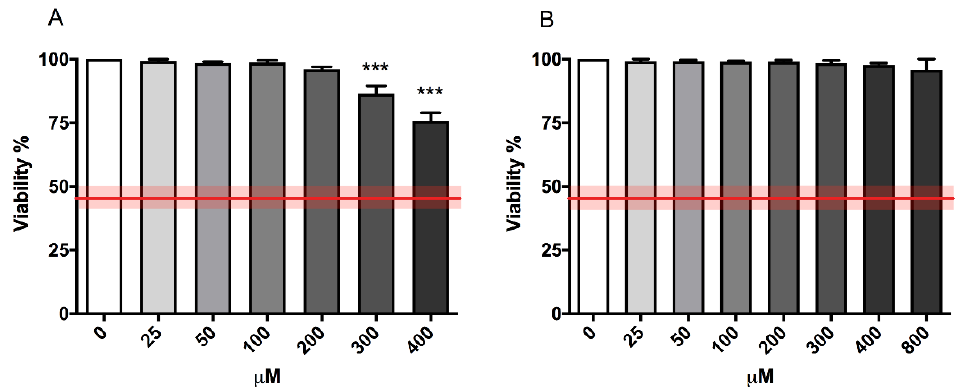
Figure 1. Cell viability of TK6 cells after 26 h treatment with ( ± )cis-4,4 (cid:48) -DMAR ( A ) or ( ± )trans- 4,4 (cid:48) -DMAR ( B ) at the indicated concentrations compared to the concurrent negative control [0 µ M]. Each bar represents the mean ± SEM of three independent experiments. Data were analysed using one-way repeated measures ANOVA followed by Dunnet as post-test. *** p < 0.001 vs. [0 µ M]. The red line represents the OECD threshold for viability (45 ± 5%).